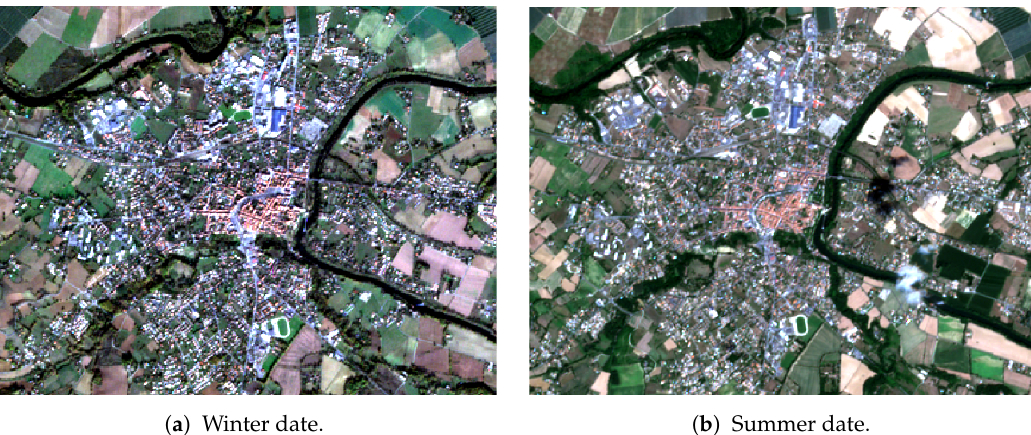
Figure 8. RGB bands of two of the 33 dates of the Sentinel-2 time series, zoomed on a 1000 × 900